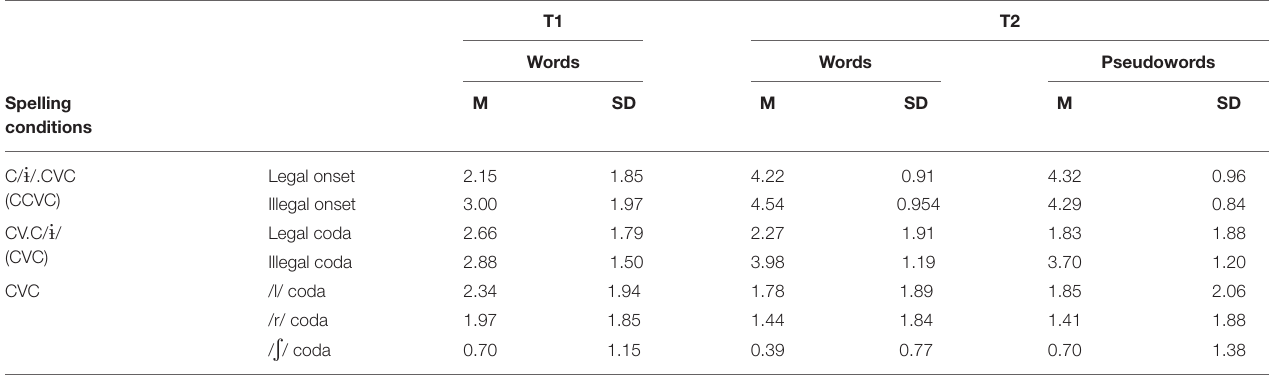
TABLE 4 | Means and standard deviations of the spelling of the schwa with < e > in C/ 1 /.CVC (CCVC) and CV.C/ 1 / (CVC) stimuli and the spelling of < e > after CVC coda. T1